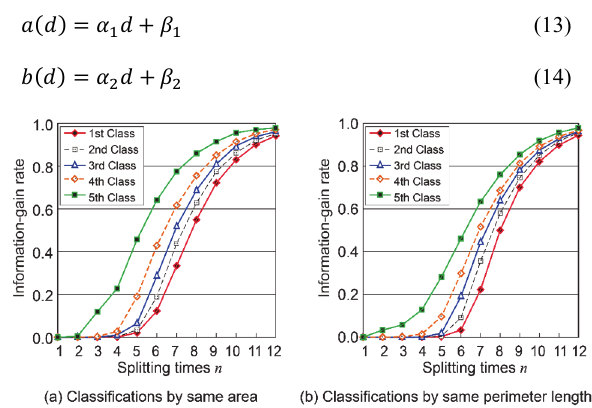
Figure 10 . Information-gain rate for virtual map.